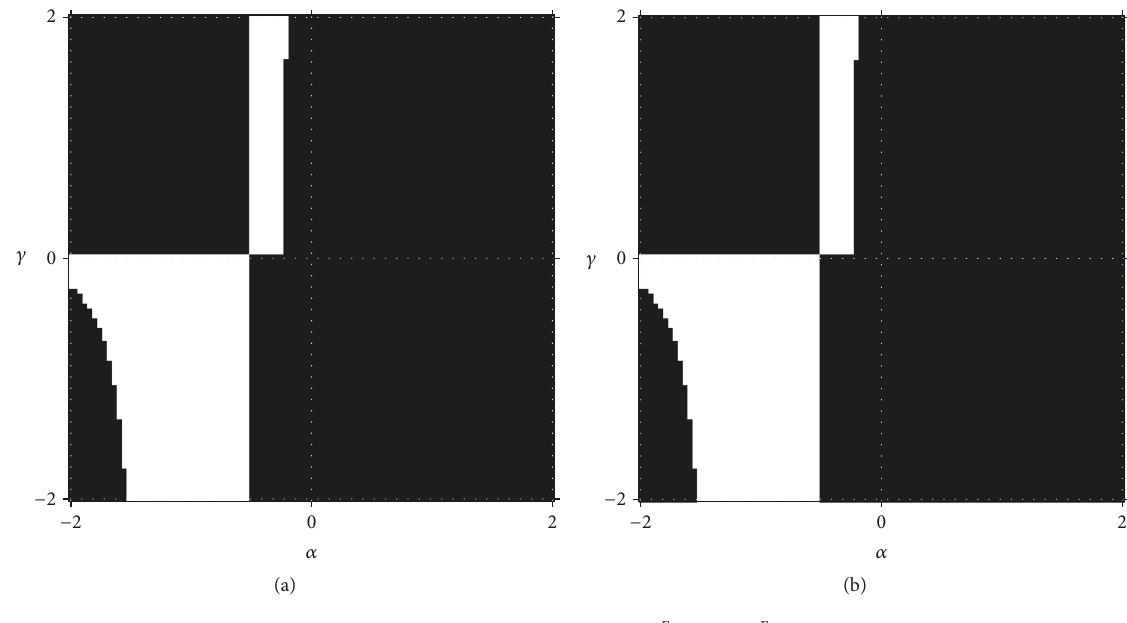
Figure 1: Stability plane of (a) 𝑥 𝐹 3 and (b) 𝑥 𝐹 4